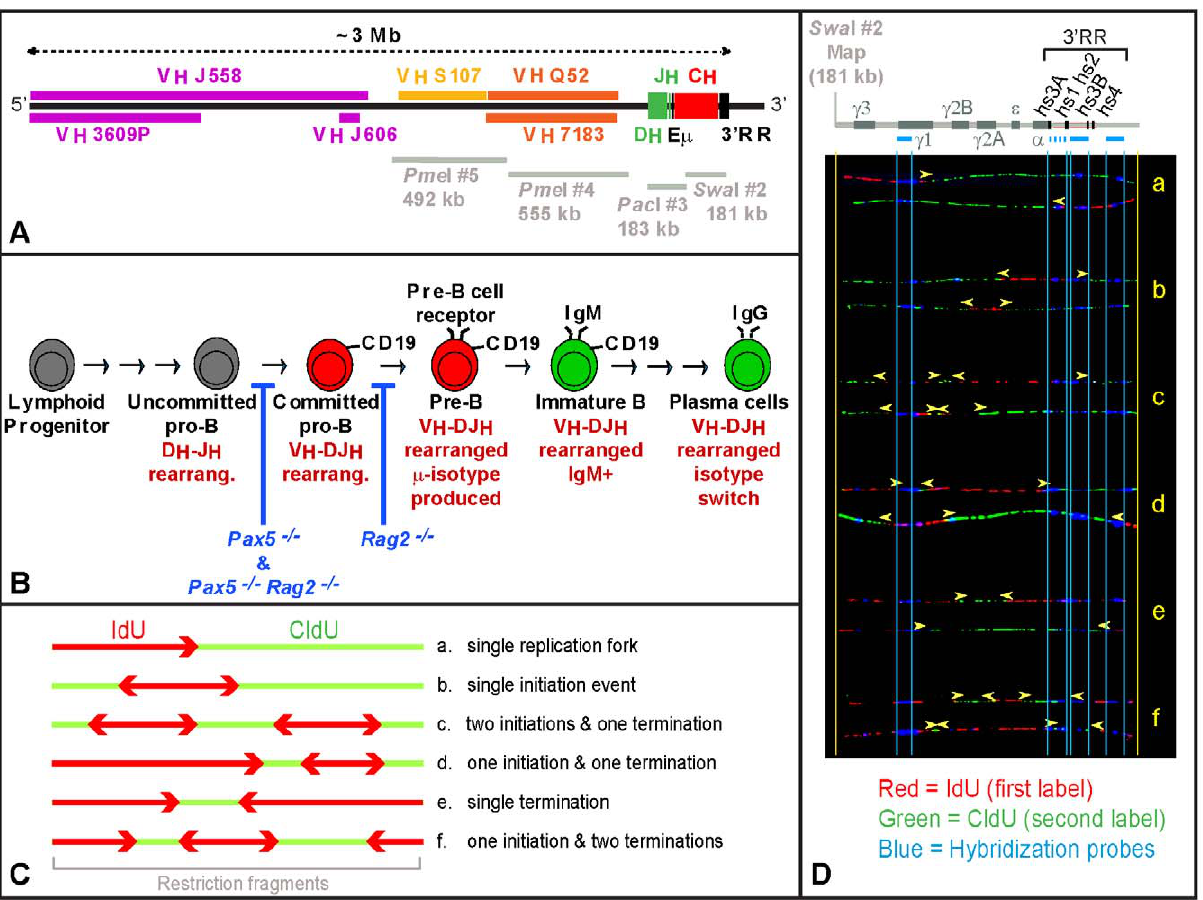
Figure 1. Experimental system and approach used in this study. (A) Map of the Igh locus (129/Sv) with approximate positions of the various gene families—constant (C H ), joining (J H ), diversity (D H ), proximal-variable (proximal-V H ; V H 7183 , V H Q52 ), middle-variable (middle-V H ; V H S107 ), distal- variable (distal-V H ; V H J606 , V H J558 , V H 3609P )—and regulatory elements—intronic enhancer (E m ), and 3 9 regulatory region (3 9 RR). Gray bars indicate the positions of the four restriction fragments analyzed in this study. Note that while PmeI # 5 and PmeI # 4 span a continuous portion of the locus, a gap of , 20 kb is present between the right end of PmeI # 4 and the left end of PacI # 3. A short overlap is also present between PacI # 3 and SwaI # 2. (B) Schematic representation of B cell development. Rag2 mediates the step of DNA cleavage during D H -J H and V H -DJ H recombination. When this gene is mutated, cells cannot assemble the pre-B cell receptor and are unable to develop beyond the committed pro-B stage of differentiation. In contrast, Pax5 regulates the expression of hundreds of genes involved in B cell commitment, and in its absence, cell differentiation stops at the uncommitted pro-B cell stage. (C) SMARD. a–f represent examples of staining patterns for six hypothetical double-labeled DNA molecules. Diverging and converging forks indicate the occurrence of initiation and termination events. (D) Images of 12 actual molecules representative of the categories depicted in panel C. Each image is aligned to the map of the corresponding genomic fragment using the position of ‘‘landmark’’ hybridization probes as a reference. Arrowheads mark the position of the IdU-CldU